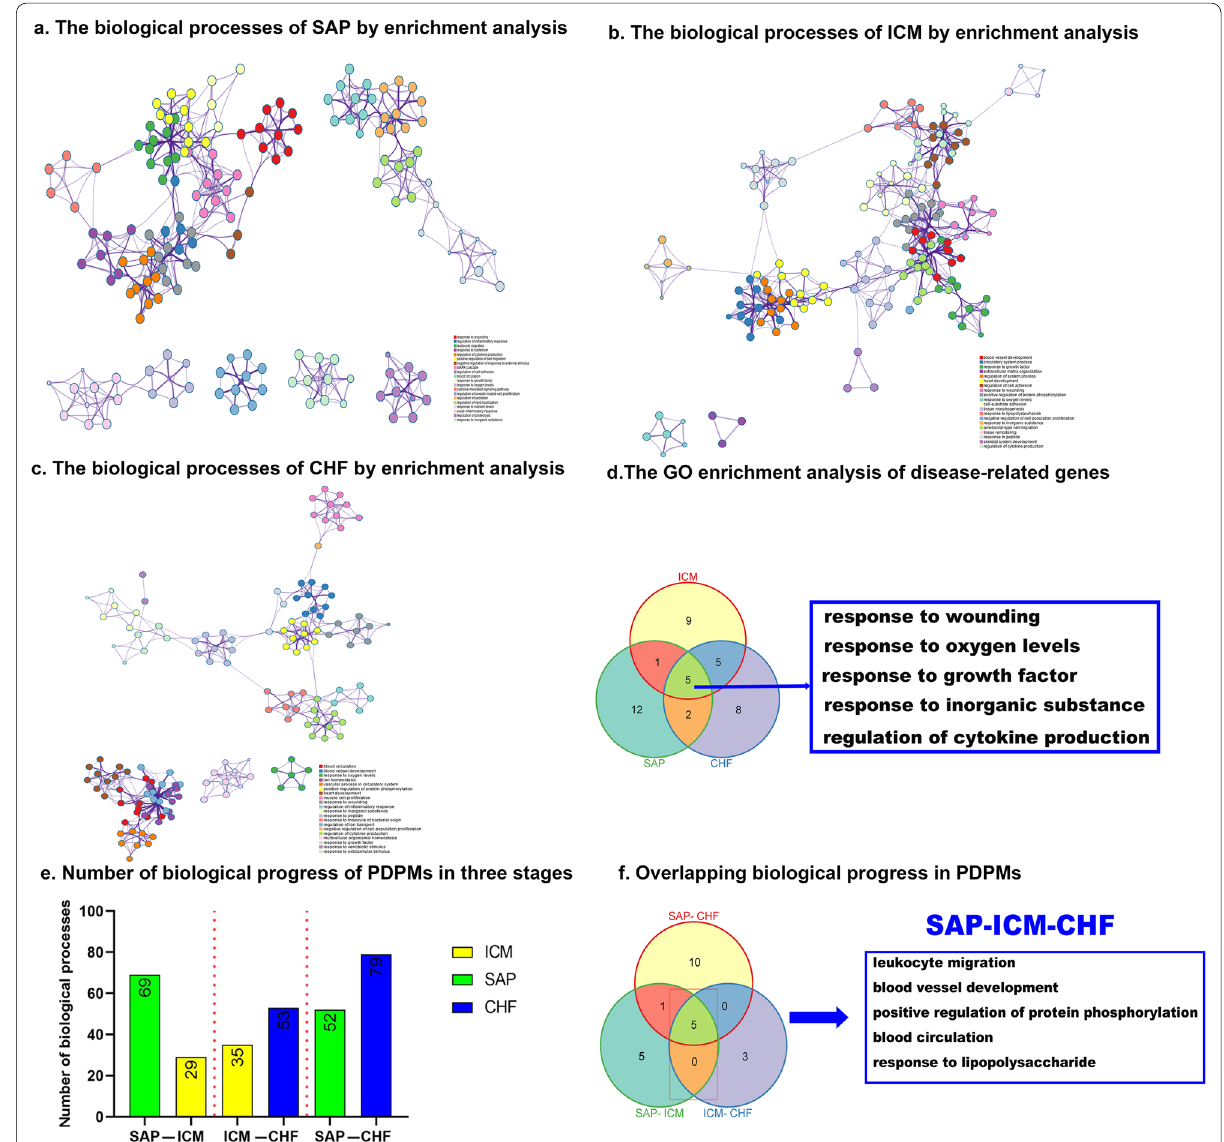
Fig. 4 The biological process enrichment analyses of disease‑related genes and PDPMs. a Top 20 biological process enrichment analyses